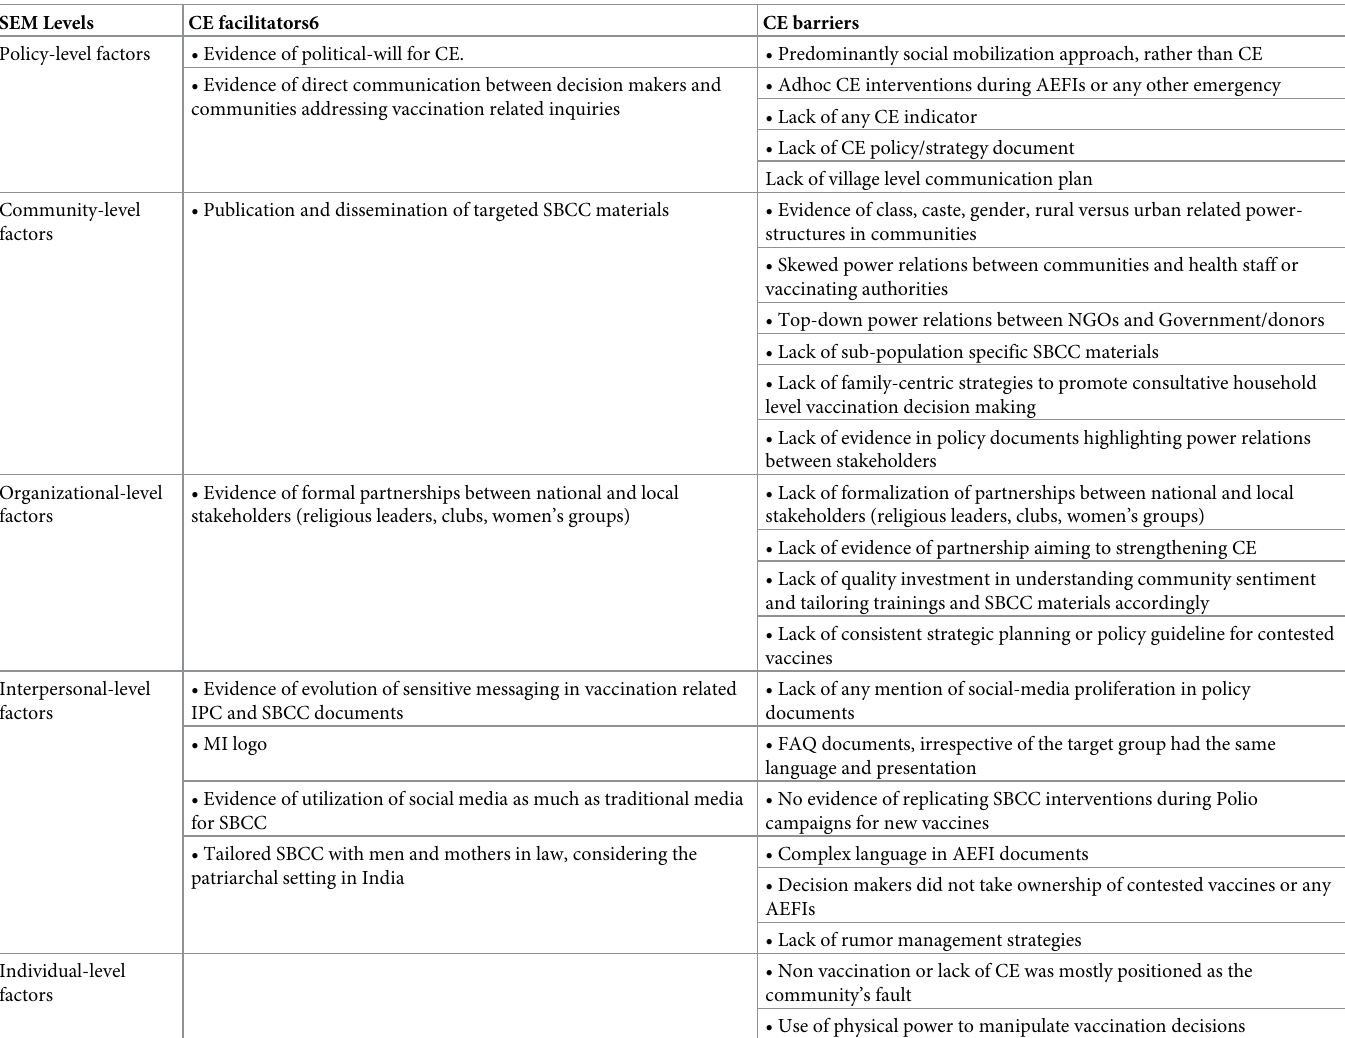
Table 2. Summary of Community Engagement (CE) enablers and barriers for vaccination in India reported by national-level vaccine decisionmakers and policy documents, by levels of Socio-Ecological Model (SEM), 2018. SEM